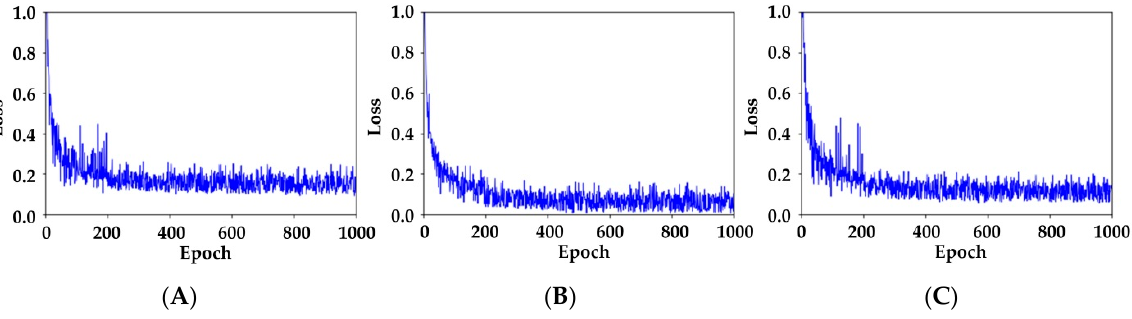
Figure 9. Losses with different learning rates. ( A ) learning rate of 0.002; ( B ) learning rate of 0.001; ( C ) learning rate of 0.0001. ( C ) learning rate of